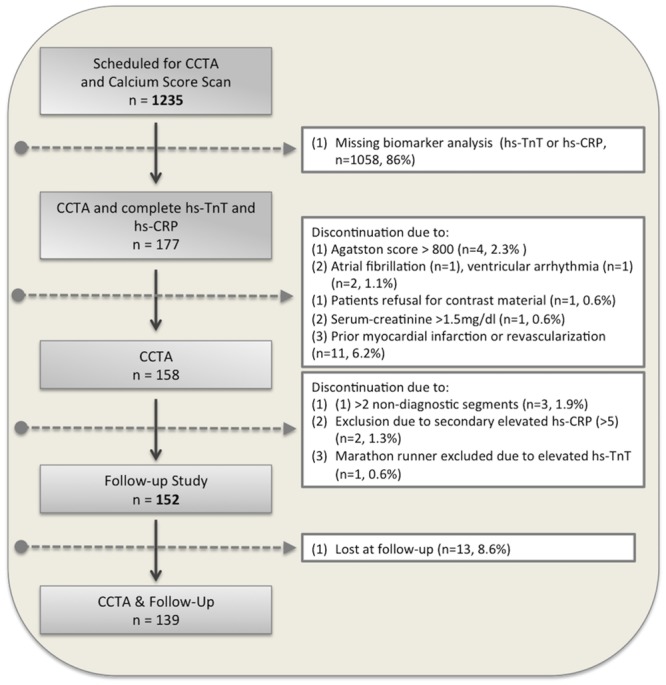
Flow diagram of patient enrolment.